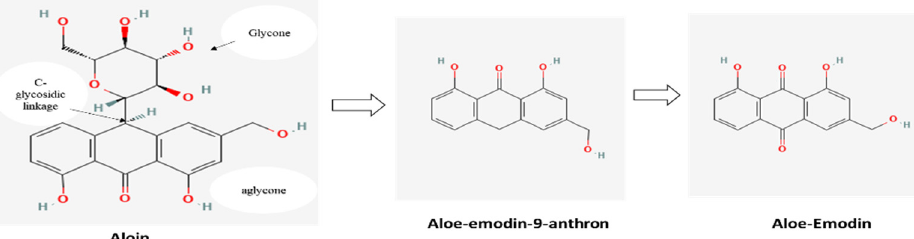
Figure 5. Hydrolysis of aloin into aloe-emodin-9-anthrone and subsequent oxidation to aloe-emodin, a free anthraquinone.